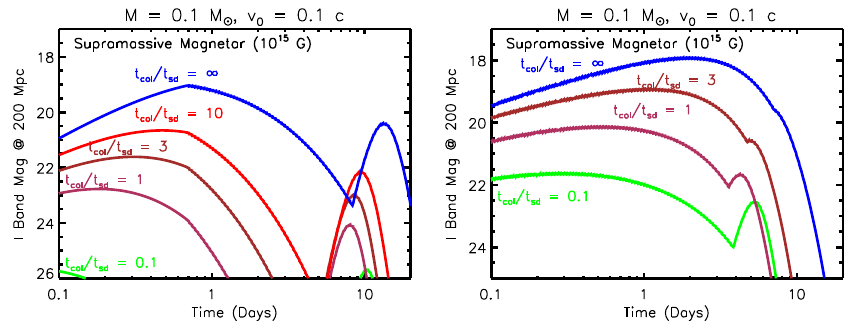
Fig. 12 I band light curves for a magnetar with a field strength of 10 15 G and a variable lifetime t col in units of the spin-down timescale t sd (cid:9) 150 s (shown as different colored line ). Other ejecta parameters are identical to those in Figs. 10, 11. The calculation shown in the left panel assumes opacities appropriate to Lanthanide matter, while the right panel assumes Lanthanide-free